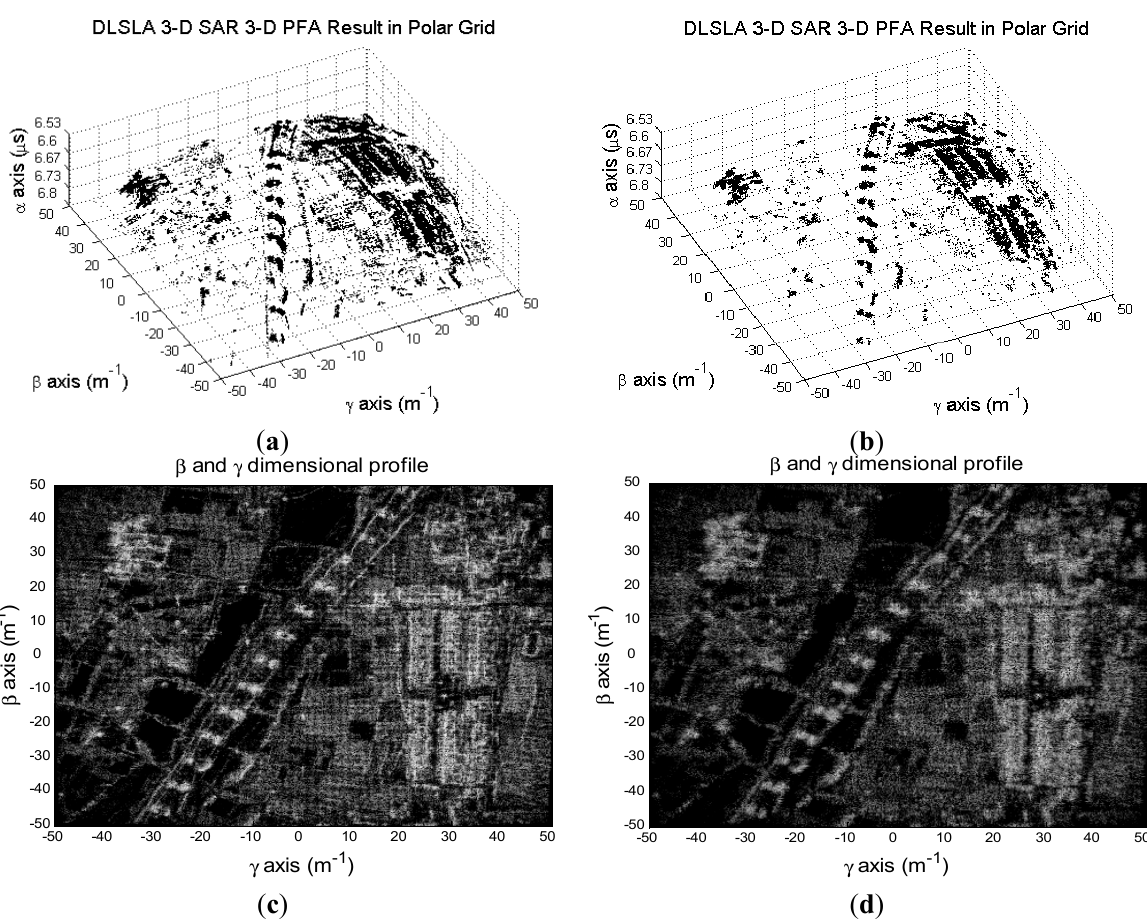
Figure 16. Imaging result in (β, γ, α) coordinates: ( a ) 3-D image without compensation. ( b ) 3-D image with compensation. ( c ) Imaging result projection onto βγ plane without compensation. ( d ) Imaging result projection onto βγ plane with